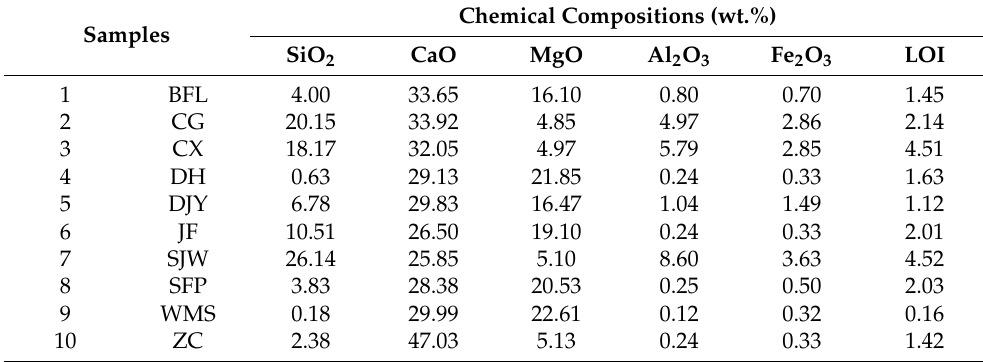
Table 2. Chemical analysis of aggregates (wt.%).